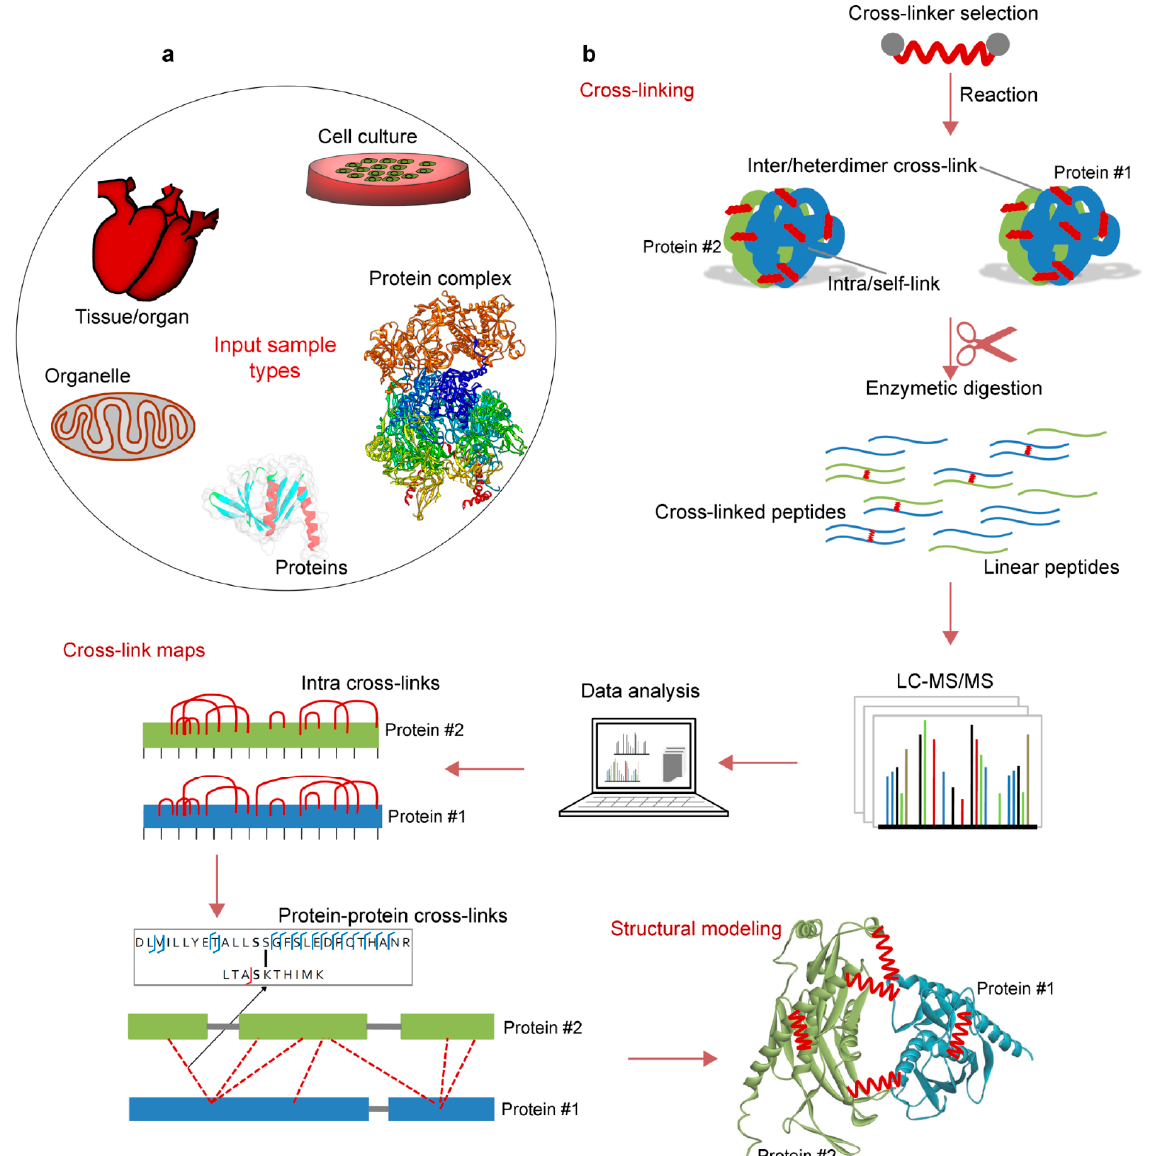
Figure 2. The generic workflow of cross-linking mass spectrometry (CLMS) experiments. ( a ) A wide range of samples (from purified proteins to intact tissues and organs) applicable to perform CLMS experiments [11,80]. ( b ) In a representative CLMS workflow, a selected linker is applied to the sample and the cross-linking reaction is carried out. Depending on the actual chemistry of interest, the reaction is stopped through chemical quenching or removal of the reagents. The proteins can be then digested in solution or gel to produce a mix of cross-linked and linear peptides. Prior to mass spectrometry analysis, the cross-linked peptides are often enriched by chromatographic methods, for example, the size exclusion chromatography, ion exchange chromatography, or purification through an affinity tag. Finally, the sample is subjected to LC-MS/MS (Liquid chromatography-tandem mass spectrometry) acquisition pipelines that have been developed to add the likelihood of selecting cross-linked peptide precursors for fragmentation. Using a variety of search software, two linked peptides can be identified from spectra and through the methods determining the false discovery rate, the list of matches can be filtered to the desired confidence. The cross-links can be also visualized by integrative modeling techniques. CLMS techniques convey the structural information in the form of distance restraints on single protein, protein complexes and allows to portray protein networks [11,80–82]. In this figure the structures of protein or peptides were prepared using BIOVIA